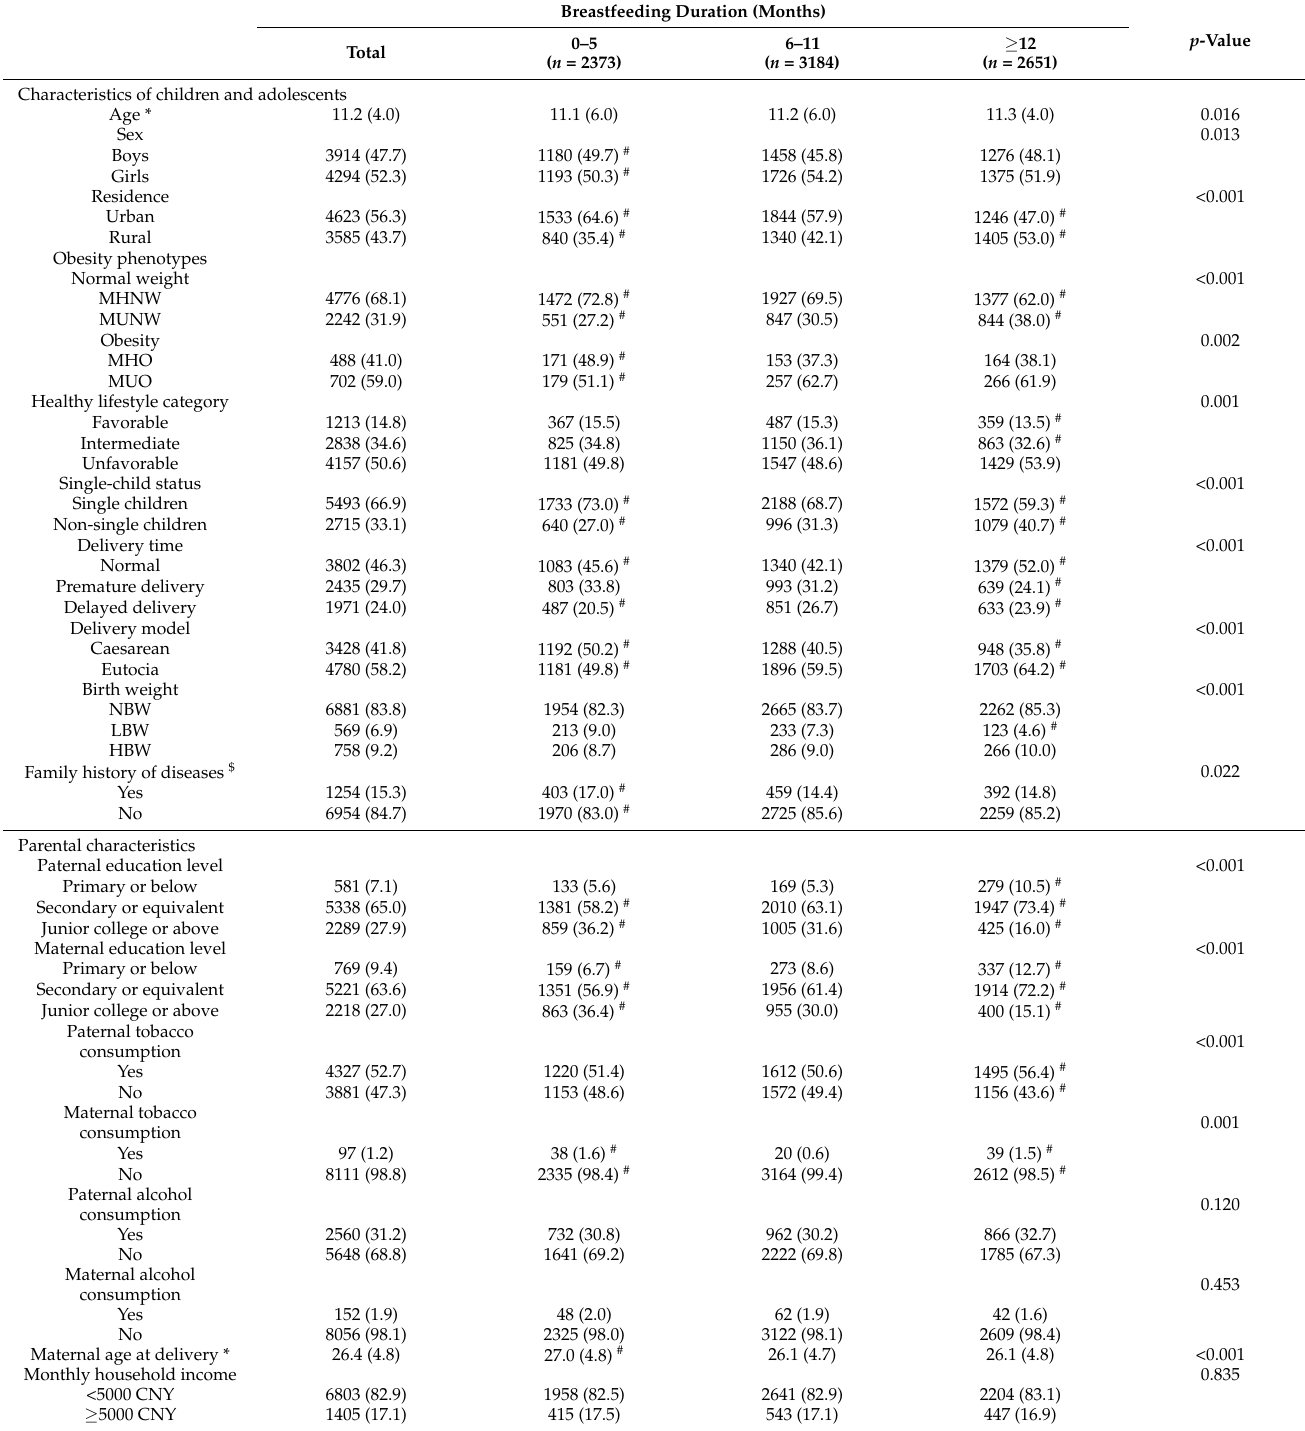
Table 1. Demographic characteristics of eligible children and adolescents and their parents, stratified by breastfeeding duration ( n =